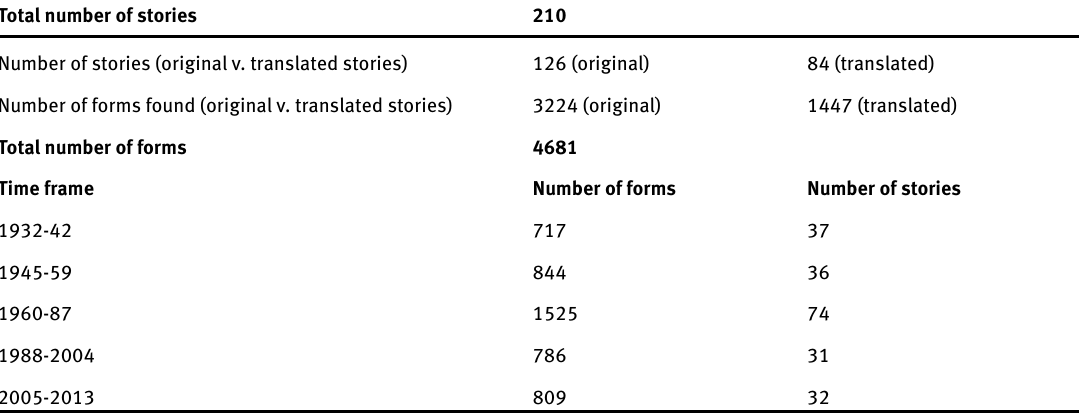
Table 1. Table offering data on the total number of stories and forms included in the corpus Total number of